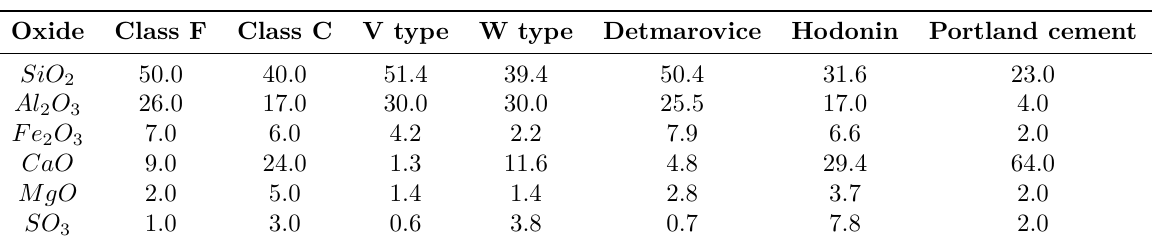
Table 2. Oxide analysis in weight percentage [%] of fly ashes an Portland